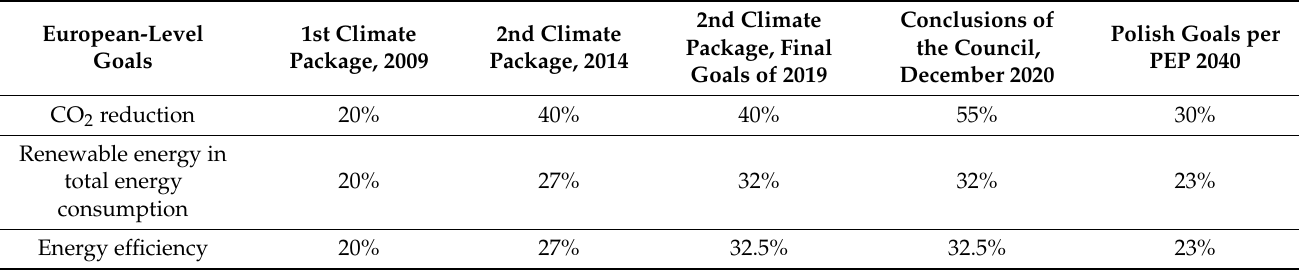
Table 1. Goals of the Polish Energy Policy for 2040 relative to the objectives of the European climate and energy policy. European-Level Goals